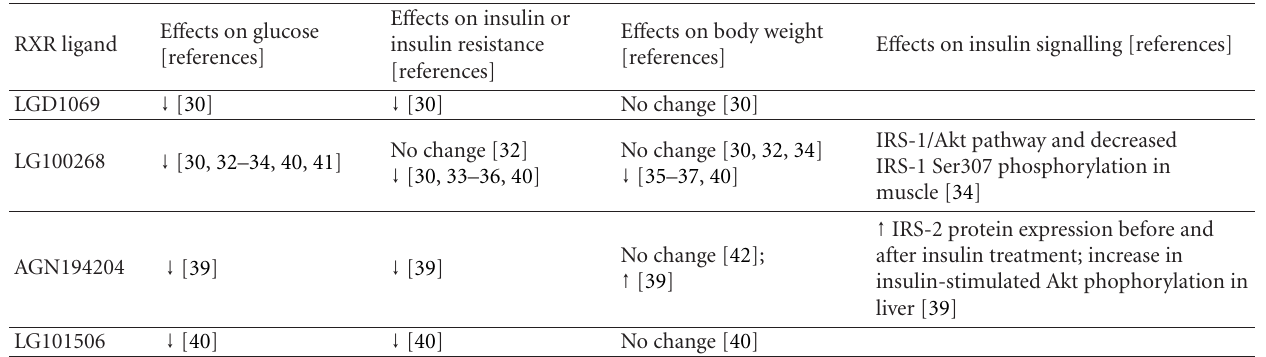
Table 2: Summary of the e ff ects of RXR-specific ligands on glucose, insulin resistance, and